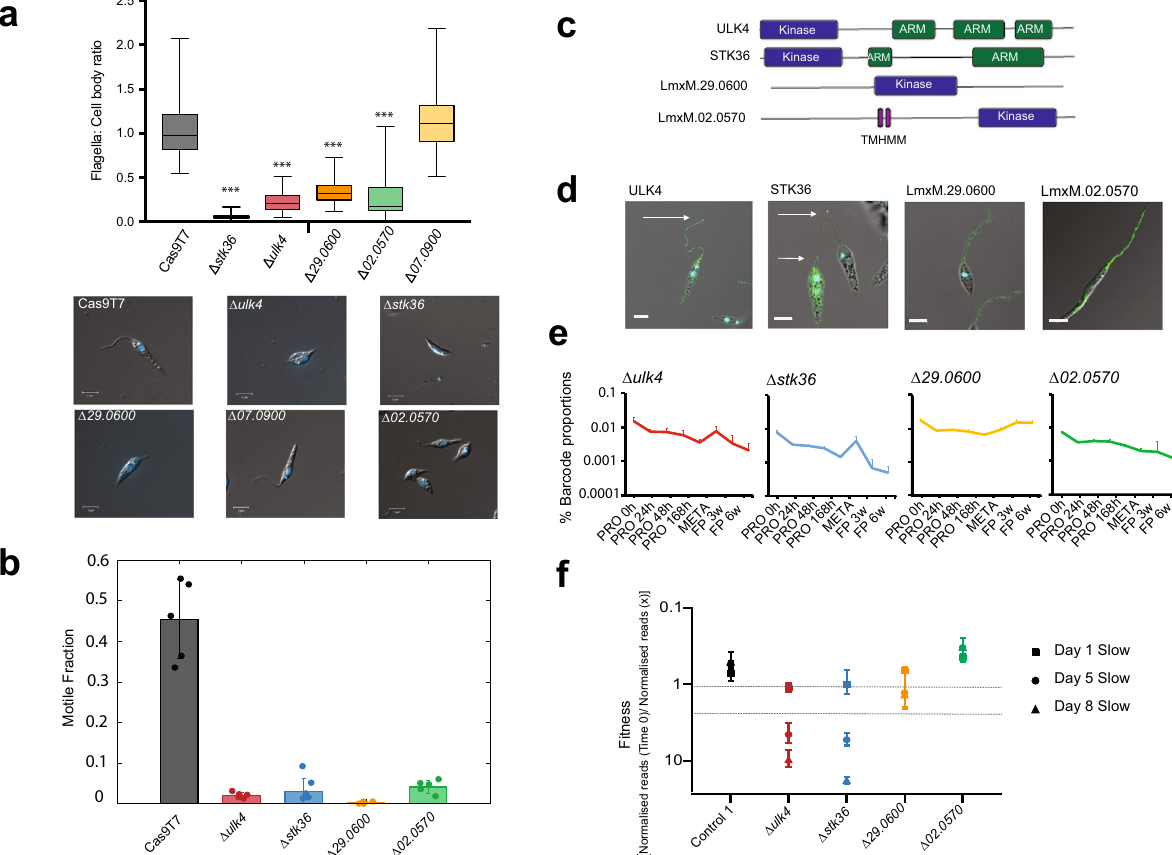
Fig. 6 Identi fi cation of protein kinases involved in motility. a Bar chart showing fl agellar length: cell body length ratio for 5 protein kinase-de fi cient mutants identi fi ed with signi fi cant loss of representation at the top of the transwell, indicating a motility defect. Error bars indicate standard deviation ( n = 50 cells for all samples except Δ ulk4 where there were 43 cells in the analysis). Mutants with a signi fi cant difference in fl agella:cell body ratio when compared to Cas9T7 were identi fi ed using an unpaired t -test with post-Welch ’ s correction (*** Δ ulk4 p = 1.07e − 25; Δ stk36 p = 1.93e − 27; Δ 29.0600 p = 1.01e − 22 and Δ 02.0570 p = 1.84e − 21). b Graph showing the fraction of the population for each promastigote protein kinase mutant progressively swimming. Five sample chambers were prepared for each cell type. The motile fraction of cells in the control ( Cas9T7 , n = 2532 cells) and four mutant strains: Δ ulk4 ( n = 2936 cells), Δ stk36 ( n = 4896 cells), Δ 29.0600 ( n = 2623 cells) and Δ 02.0570 ( n = 3532 cells). The error bars represent standard error of the mean/95% con fi dence intervals and the data points denote results from individual chambers. c Schematic showing the protein structures of the four protein kinase mutants identi fi ed in the motility screen. d Localisation of the proteins tagged with mNeonGreen. e Bar-seq trajectories for the four protein kinase mutants for Pool 1, EA3 with loss-of- fi tness analysed using multiple t-test corrected with post Holm – Sidak method (values are mean ± S.D., n = 6 biologically independent samples). f normalised bar-seq reads for these four protein kinase mutants during development in the sand fl y (values are mean ± S.E., n = 2 biologically